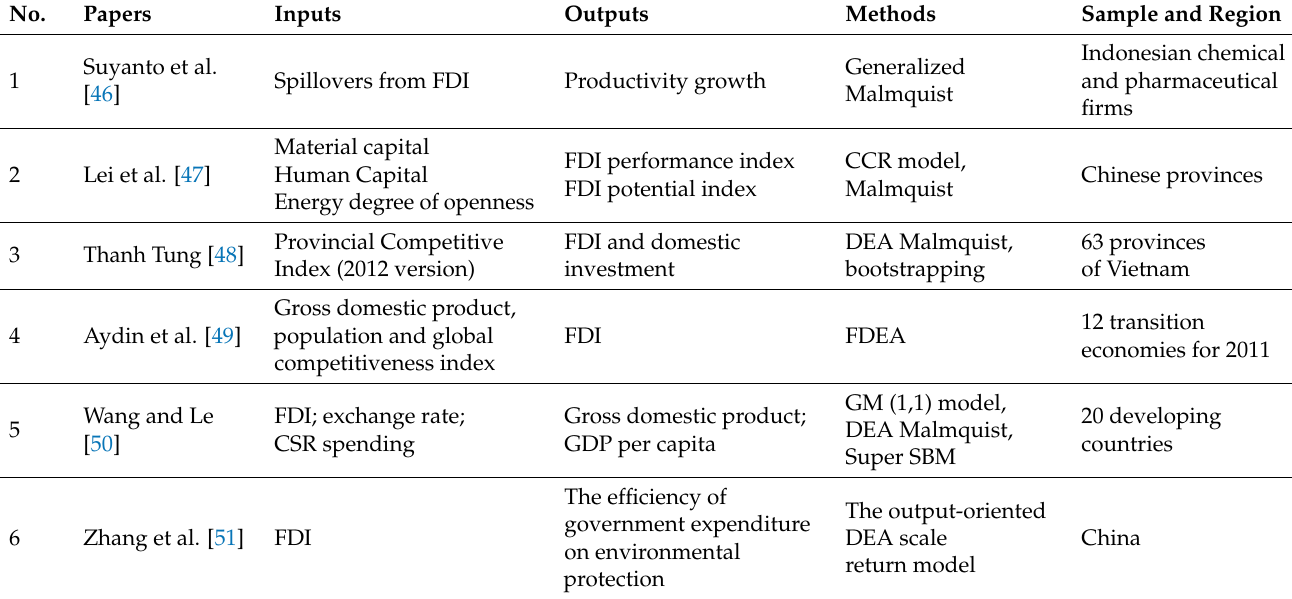
Table 2. List of related